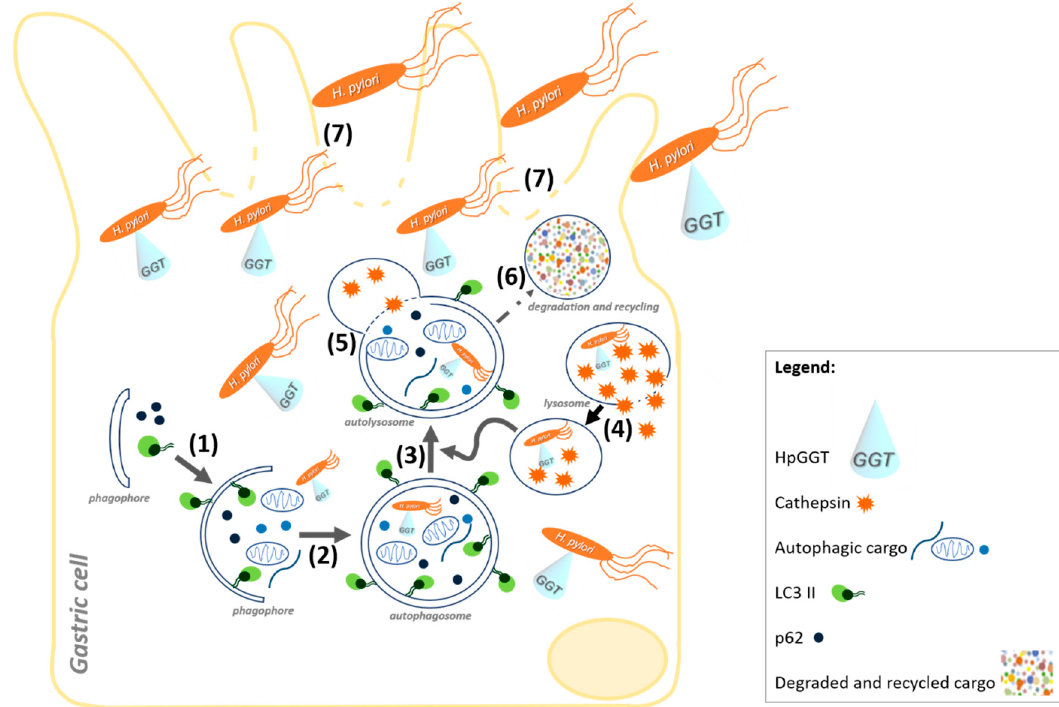
Figure 6. Schematic illustration depicting how the Helicobacter pylori ( H. pylori ) virulence factor gamma-glutamyltranspeptidase (HpGGT) acts upon infection of gastric (AGS and GES-1) cells. HpGGT is secreted and is shown to inhibit gastric cell autophagy ( 1 – 6 ) and, in the case of AGS cells, to do so by reducing levels of the lysosomal cysteine protease Cathepsin B. H. pylori is suggested in these cells to increase lysosomal membrane permeability to favor Cathepsin B leakage ( 4 ), thereby impairing lysosome degradation upon fusion with the autophagosome ( 5 ). In parallel, HpGGT is depicted as being necessary for H. pylori internalization ( 7 ) by gastric (AGS and GES-1) cells and thus as a virulence factor that facilitates bacterial invasion of gastric cells. Supplementary Materials: The following are available online at www.mdpi.com/xxx/s1. Figure S1: AGS infection with H. pylori wild type or the isogenic Hp ∆ ggt mutant induced to a similar extent the phosphorylation of AMPK and downstream targets of mTOR; Figure S2: Loss of HpGGT did not affect H. pylori adherence in gastric cells